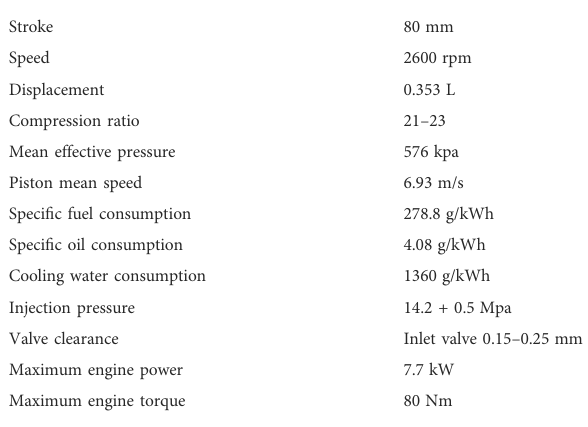
TABLE 4 Detail of the engine used in this research work.